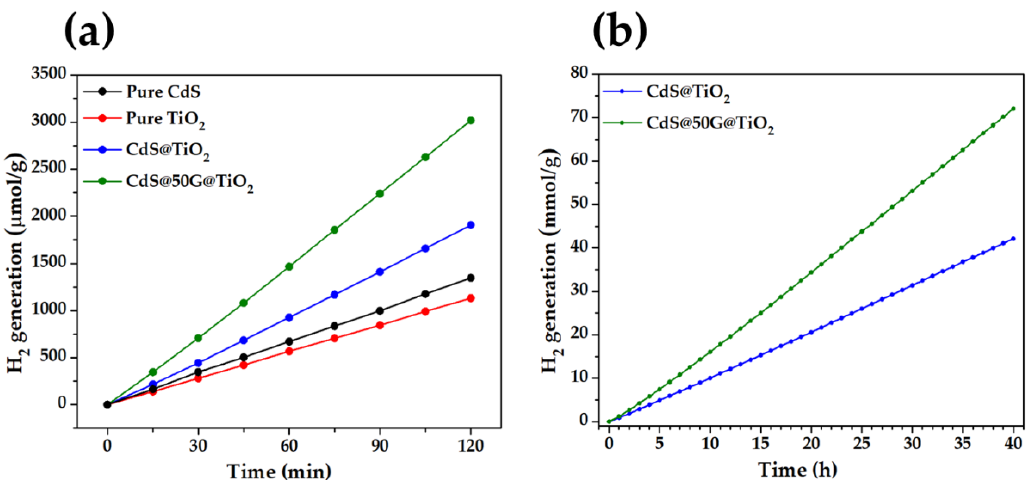
Figure 6. Photocatalytic activity tests for hydrogen generation from water employing different samples ( a ) and stability tests under the same conditions ( b ) employing 40 mg of catalysts dispersed in 600 mL DI water with 0.125 M Na 2 S and 0.175 M Na 2 SO 3 acting as hole scavengers illuminated with simulated solar light.